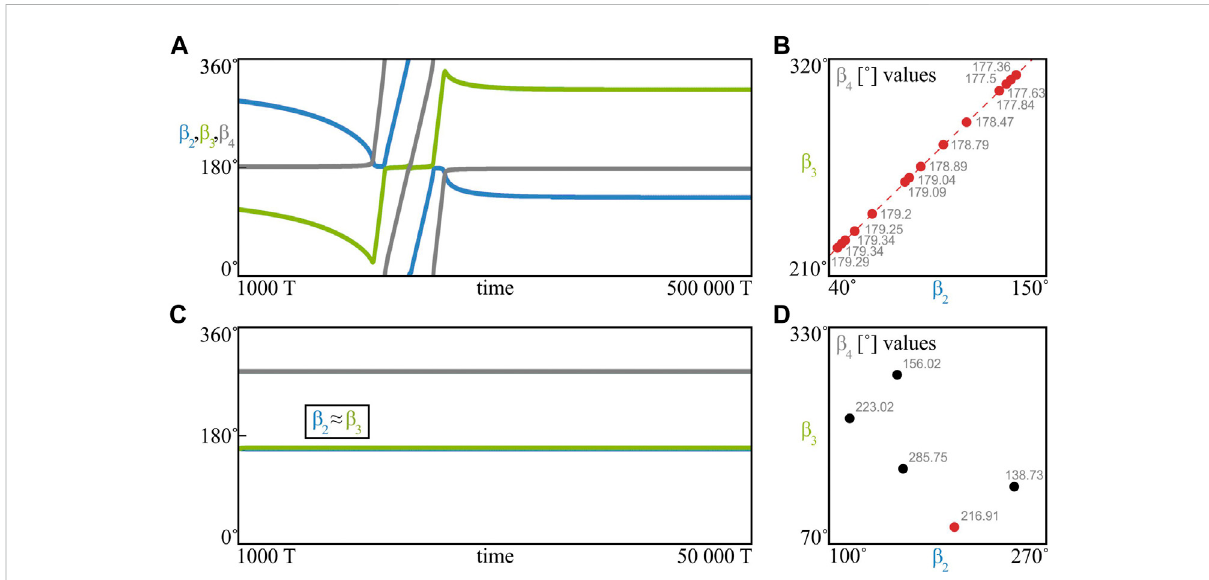
FIGURE 9 (Colouronline). Theevolutionofphases β 2 , β 3 , β 4 (leftpanel)andpossiblesynchronouscon fi gurations in( β 2 , β 3 )plane(rightpanel).Results (A,B) correspond to the case of slightly different masses: m 1 = 1.0, m 2 = 0.99, m 3 = 1.01, m 4 = 0.985 [kg], while results (C,D) have been obtained